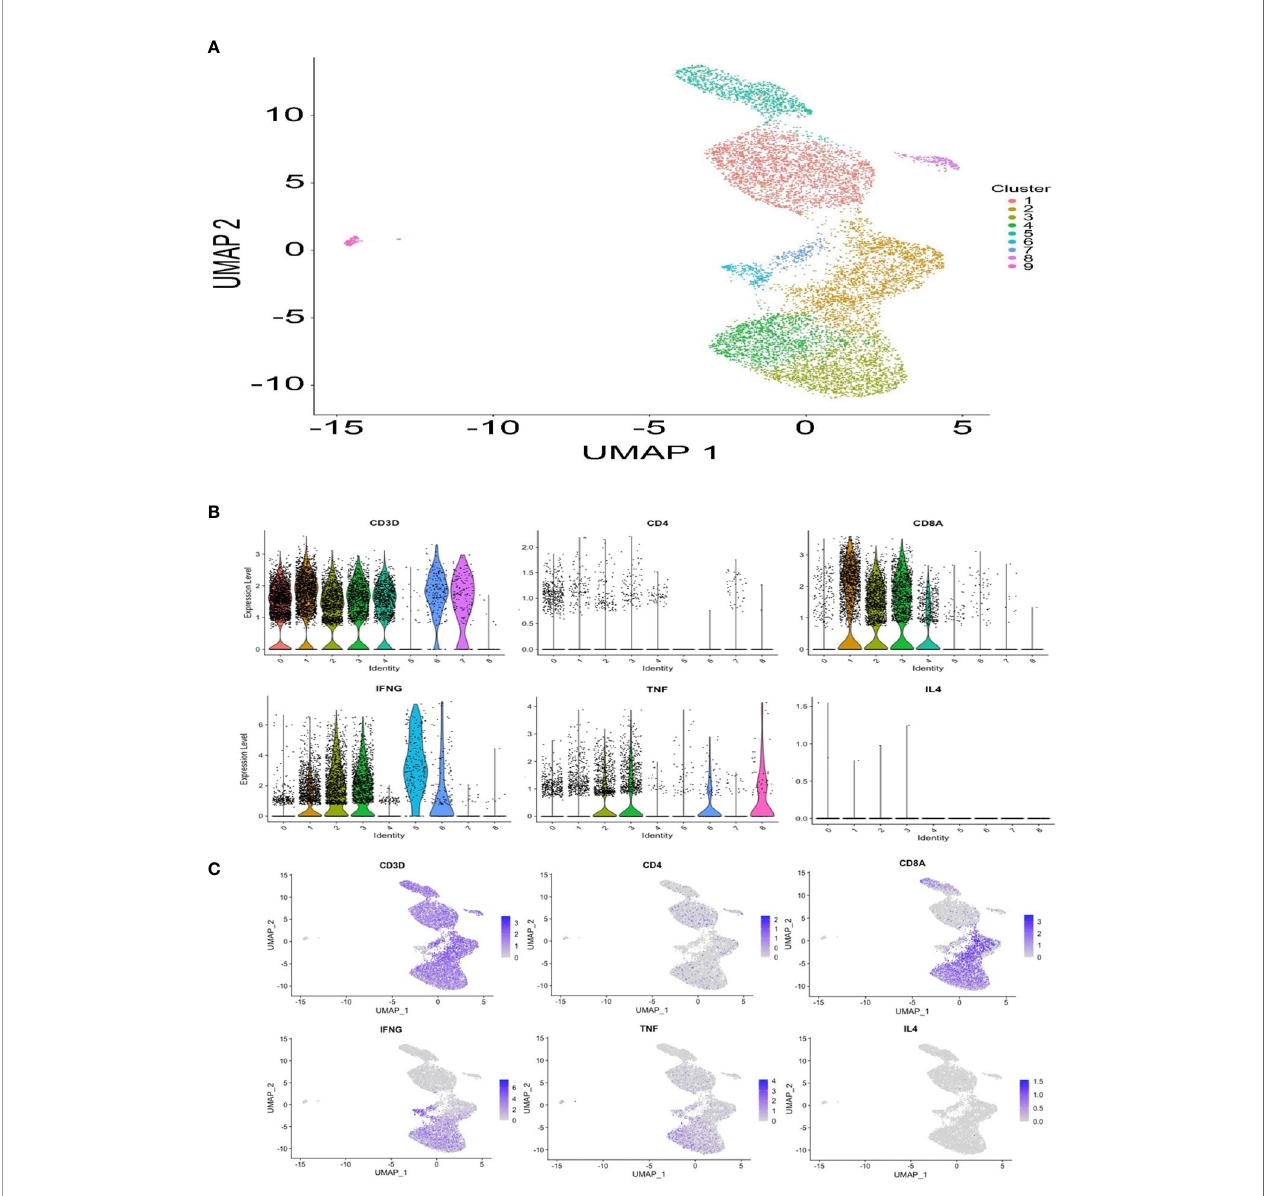
FIGURE 4 | Single-cell gene expression pro fi le of HPV 16 E6 91-115 speci fi c T cells. (A) A UMAP plot showing 9 clusters based on gene expression pro fi les. (B) Violin plots showing CD3D, CD4, CD8A, IFN- g , TNF, and IL-4 gene expression. (C) Feature plots showing CD3D, CD4, CD8A, IFN- g , TNF, and IL-4 gene